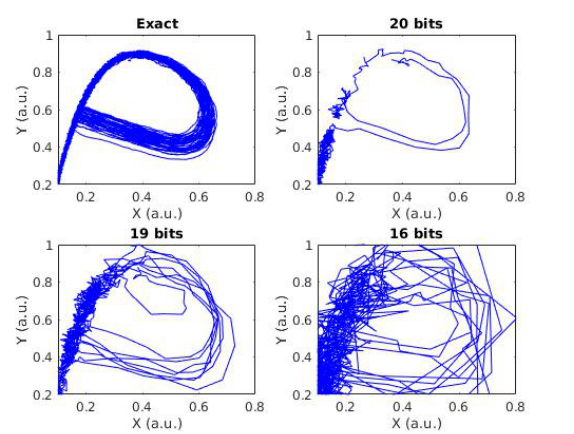
Figure 4. Space state of the x and y variables in the HR model, using conventional arithmetic (top, “exact”), and stochastic computing (20, 19, 16